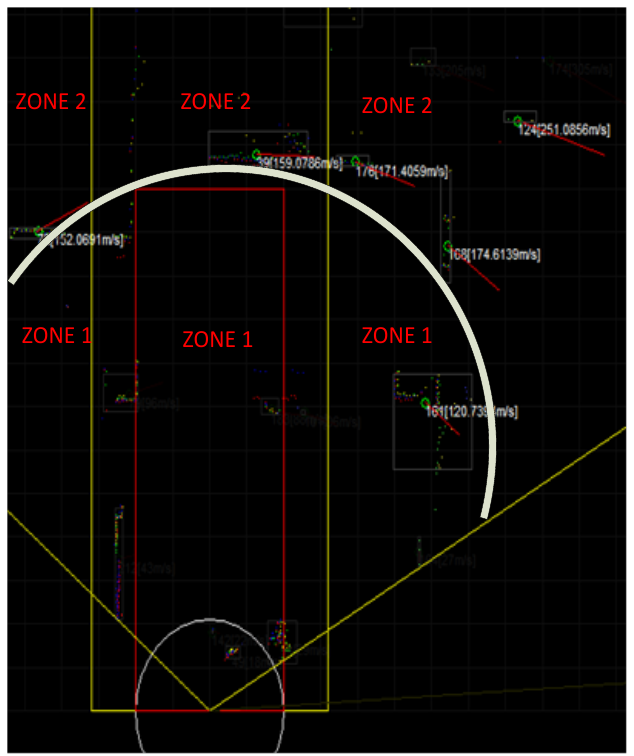
Figure 6. Dangerous areas and obstacles (static and moving) in an observed scene.